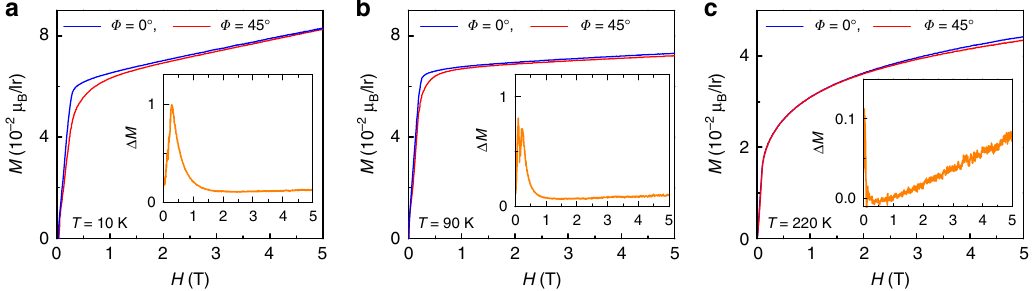
Fig. 2 Magnetic properties of Sr 2 IrO 4 . Magnetization as a function of H applied at Φ = 0 o and Φ = 45 o at ( a ) T = 10 K, ( b ) 90 K, and ( c ) T = 220 K. The inset shows the difference of magnetization measure at two